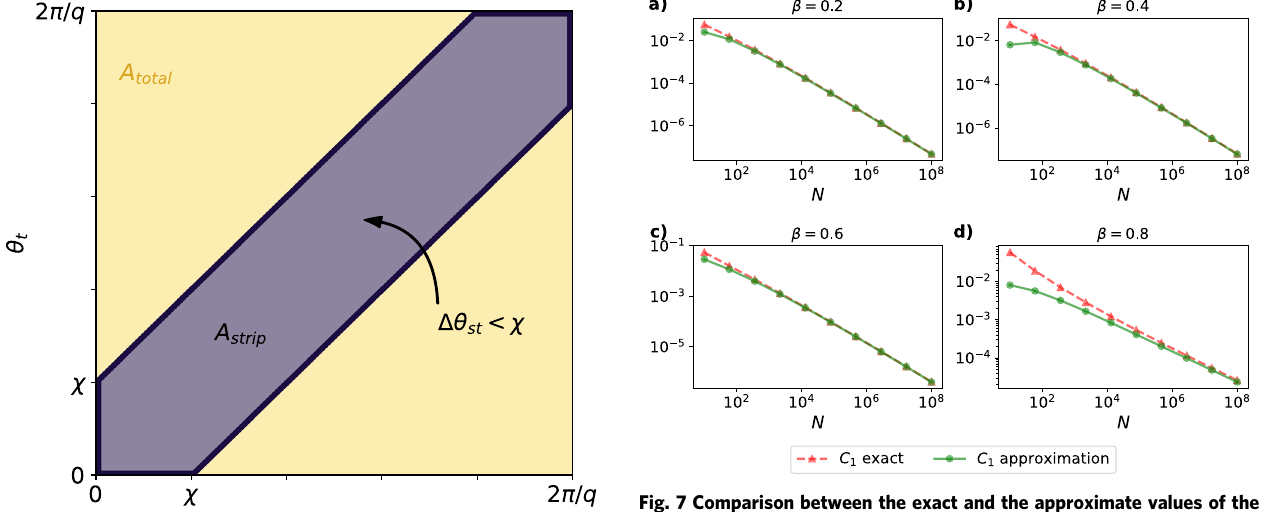
Fig. 7 Comparison between the exact and the approximate values of the parameter C 1 as a function of the system size N for different values of the popularity fading parameter β . Each panel corresponds to a different value of β , showing the exact values of C 1 with a red dashed line, whereas the approximating form of C 1 is displayed with a green solid line. In all panels a – d , we used ζ = 1, m = 2 and T = 0.1.